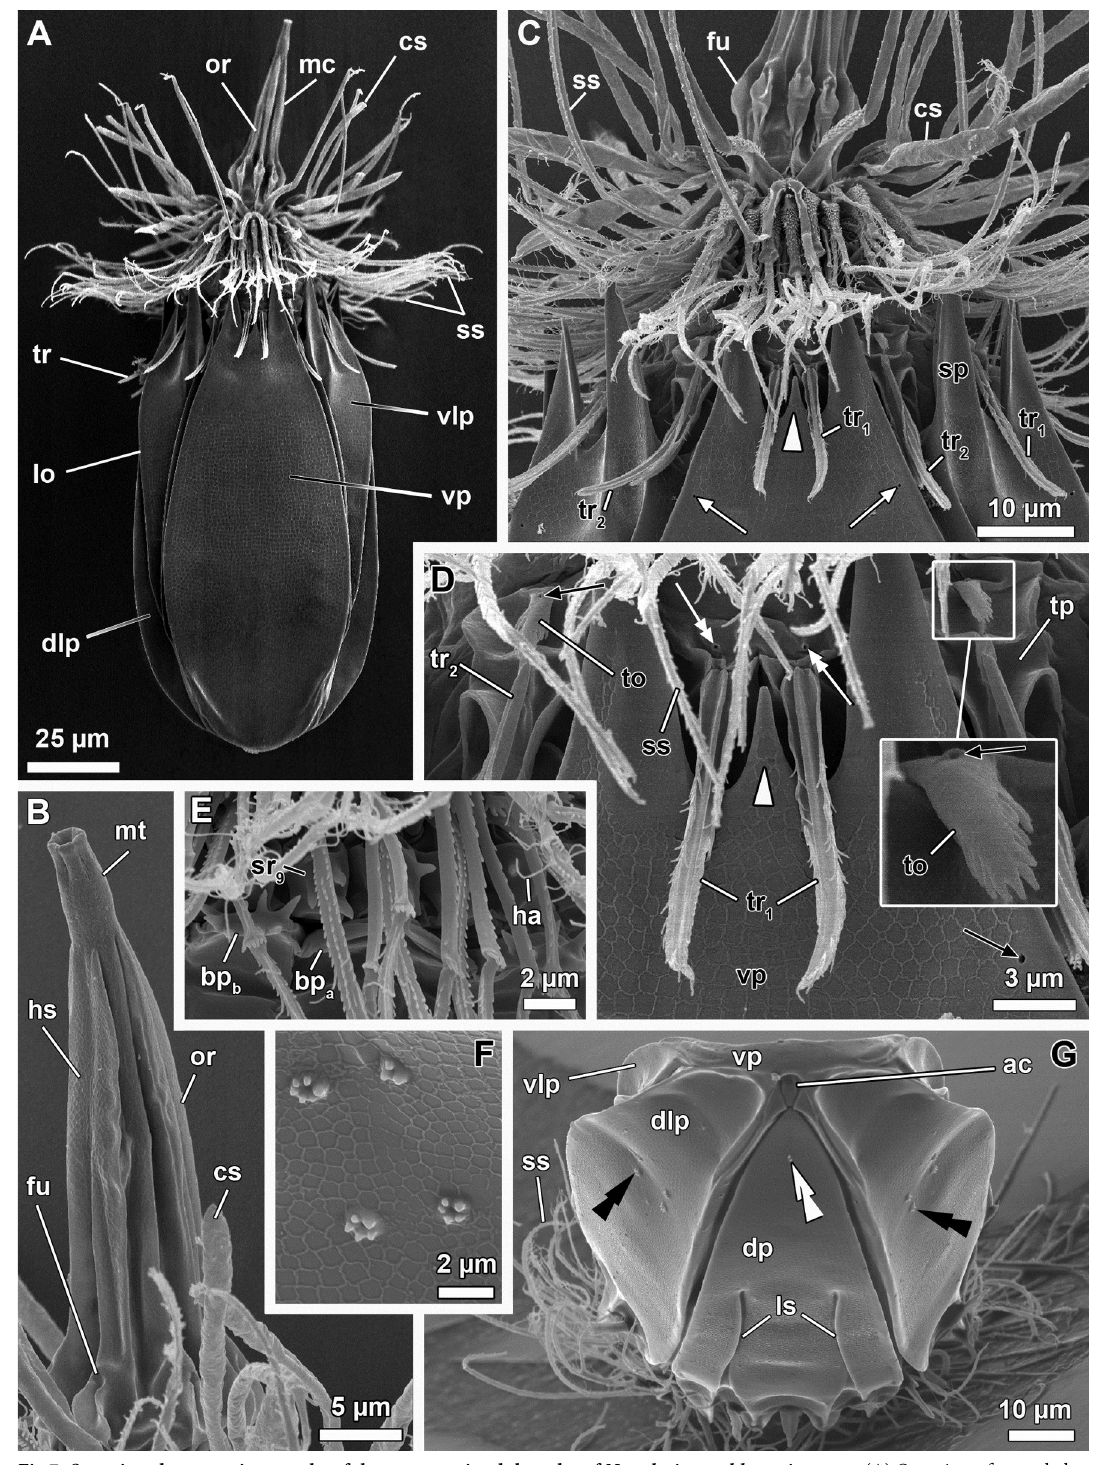
Fig 7. Scanning electron micrographs of three paratypic adult males of Nanaloricus valdemari sp. nov. (A) Overview of extended specimen, ventral view, anterior faces up. Same specimen as in C and D. Note the multiform clavoscalids: the ventralmost pair is unbranched (and similar to the eight female clavoscalids), while the others are divided into three branches. (B) Close up of the mouth tube (mt). Same specimen as in E. Note the honeycomb sculpture (hs) of the cuticle. (C) Anterior region of the body, ventral view. Note the difference between single (tr 1 ) and double trichoscalids (tr 2 ). White arrowhead points to the small midventral anterior spike. White